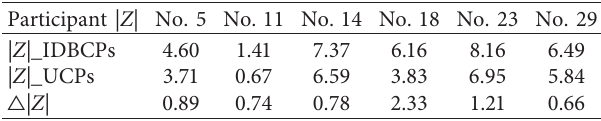
Table 4: |Z| of SDSWM calculated by UCPs and IDBCPs,